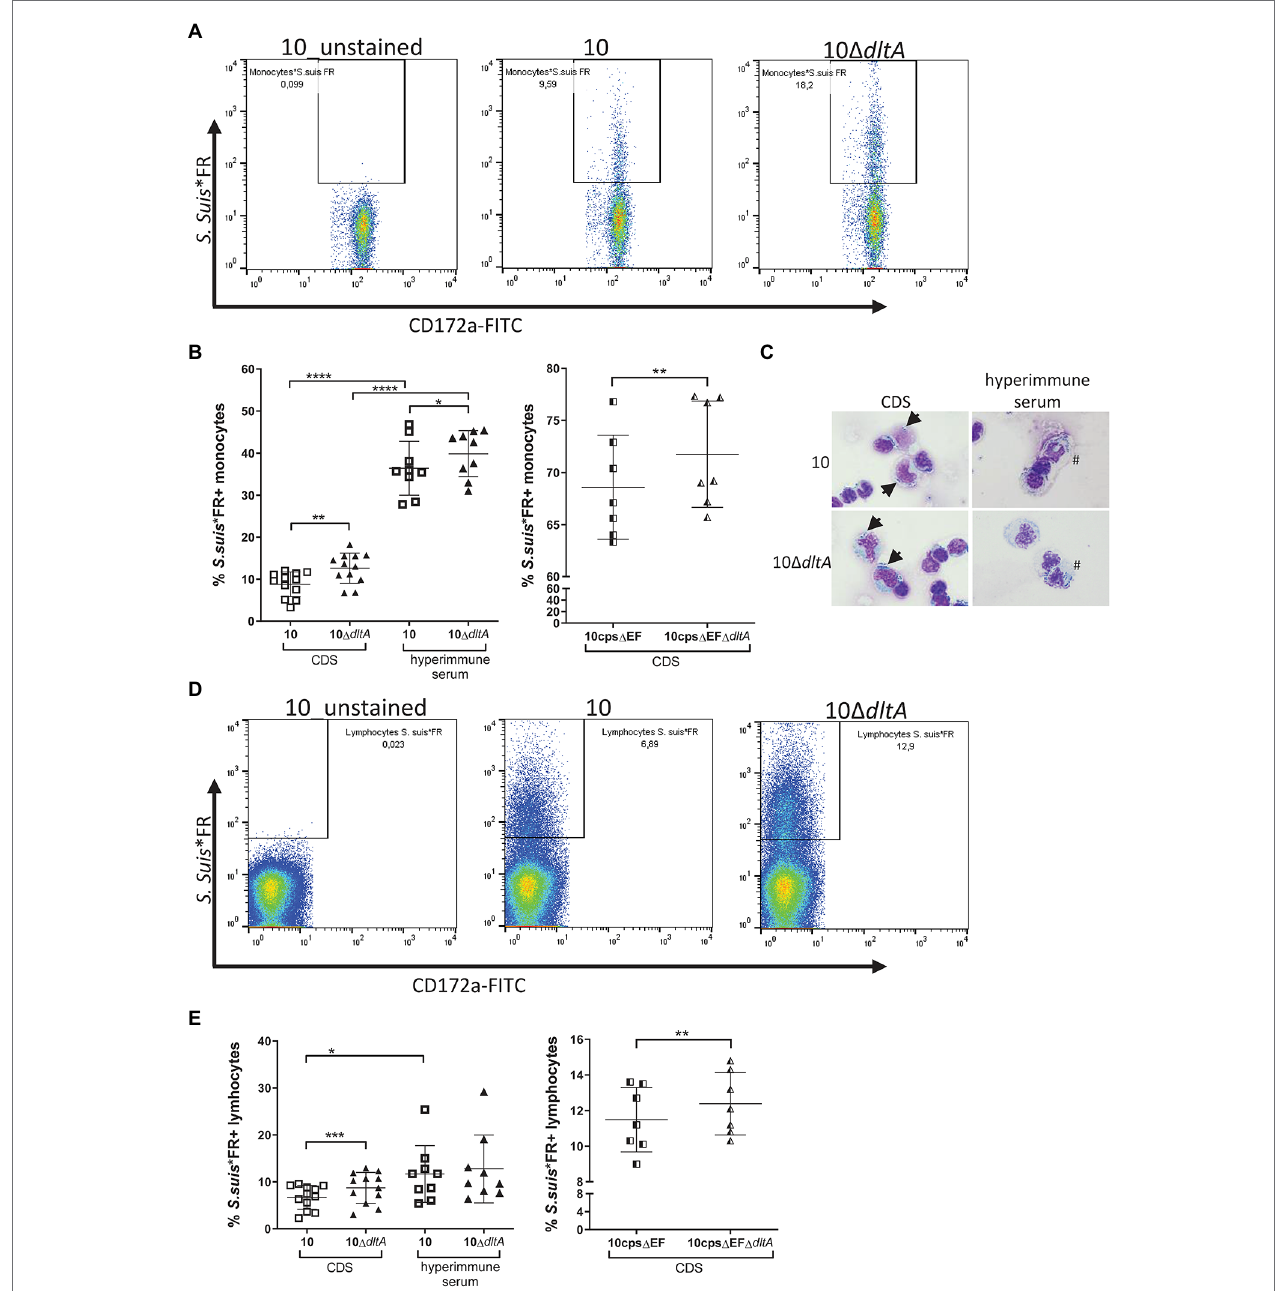
FIGURE 3 | Far Red-labeled Streptococcus suis Δ dltA mutants show a significantly higher level of association with porcine monocytes and lymphocytes. Peripheral blood mononuclear cell (PBMCs; freshly isolated from porcine blood) were incubated with Far Red-labeled S. suis strains ( S. suis *FR) at an MOI of 1 for 30 min at 37 ° C, whereby S. suis *FR had been pre-incubated in serum of colostrum-deprived piglets (CDS) or in hyperimmune serum for 30 min, as indicated. Monocytes were stained using the myeloid marker CD172a-FITCs (as visualized in Supplementary Figure S4 ) and samples were measured by flow cytometry. The gating strategy for monocytes (A) and lymphocytes (D) in association with S. suis is visualized for PBMCs of one animal, while ( B ; monocytes) and ( E ; lymphocytes) show the entire results for the encapsulated strains on the left and the non-encapsulated strains on the right. The number of symbols represents the number of piglets PBMCs were obtained from. (C) Shows exemplary pictures of CDS-treated S. suis bound to the surface of monocytes (arrow) and uptake of antibody- opsonized S. suis (#) into monocytes as visualized by optical microscopy (x400 magnification). Horizontal lines and error bars represent mean values and SDs. For statistical analysis, paired t -test (wt or 10cps Δ EF vs. respective Δ dltA mutant) or unpaired t -test (CDS vs. hyperimmune samples) were performed. In case of not normally distributed samples, Wilcoxon test or Mann–Whitney test was used. Differences that are not indicated are not significant. * p < 0.05, ** p < 0.01, *** p < 0.001, and **** p <